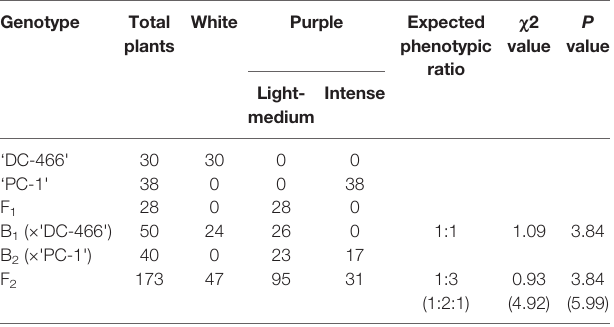
TABLE 1 | Segregation of F 2 and backcross population for curd color trait in white: intermediate: purple categories.